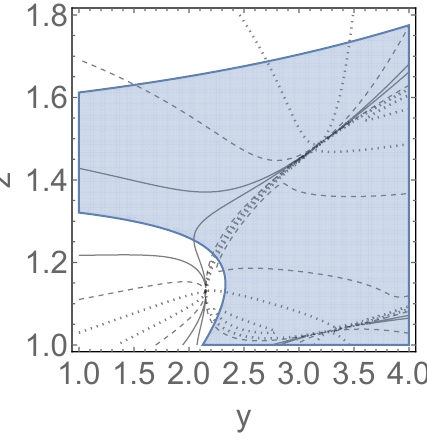
) to the ˆ3ˆ a ˆ b